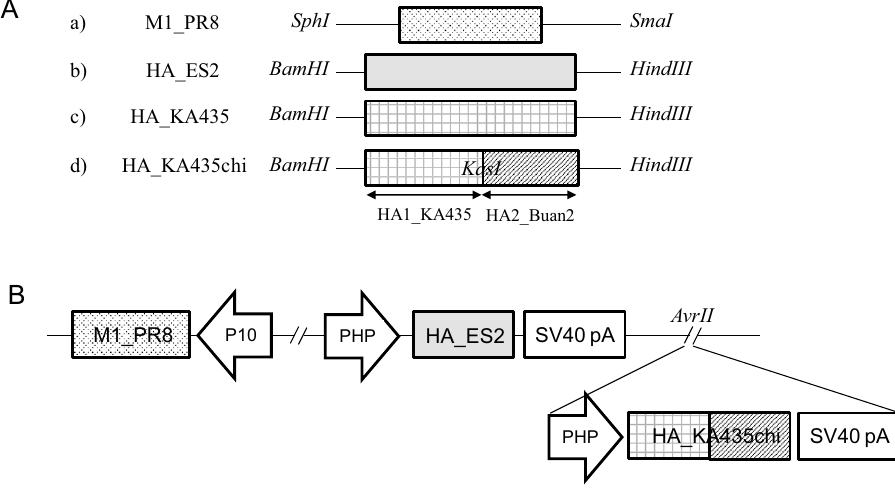
Figure 6. Baculovirus construct for production of multi-clade VLPs. ( A ) ( a ) M1 of PR8 (M1_PR8) is inserted between restriction enzyme sites for SphI and SmaI, and the HAs of ( b ) ES2, ( c ) KA435 (HA_ES2 and HA_ KA435), and ( d ) chimera of KA435 (HA_KA435chi) are inserted between restriction sites for BamHI and HindIII. ( B ) The M1 gene is under the control of the p10 promoter (P P10 ); the HA of ES2 (HA_ES2) is under the control of the polyhedron promoter (P PH ); and the HA chimera of KA435 (HA_KA435chi), inserted into the AvrII restriction site, is under the control of the polyhedron promoter (P PH